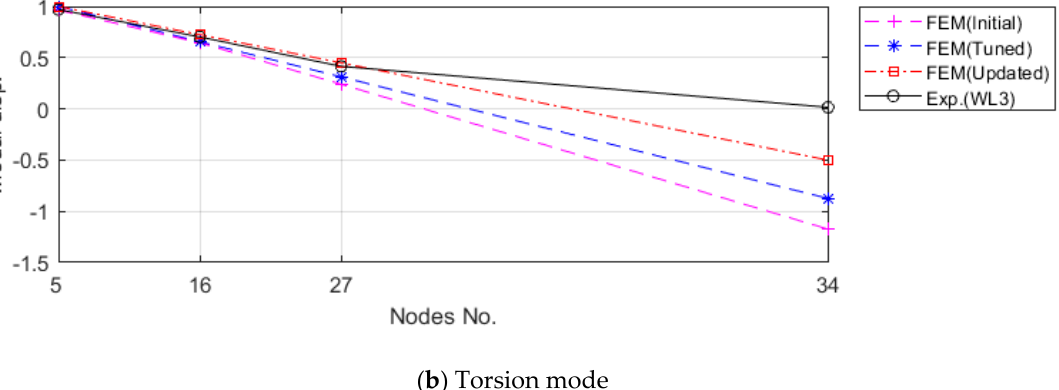
Figure 7. Plot of the vertical modal displacements along the transversal cross section. Note: The modal displacements are normalized to the maximum unity for the first thirty-three nodes.